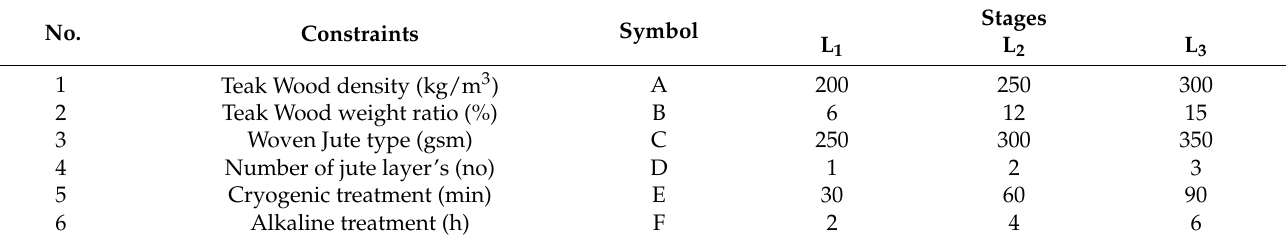
Table 1. Parameters and their